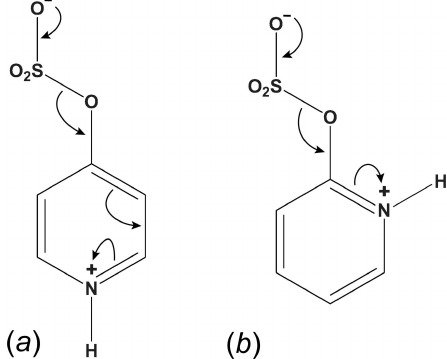
Figure 2 ( a ) A reasonable representation for the mechanism of hydrolysis for the 4-sulfate. ( b ) The o -sulfate analog ought to behave similarly.